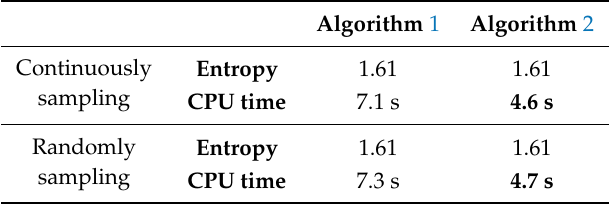
Figure 5. ISAR images obtained by the two proposed algorithms under different sampling schemes. Column 1: continuously sampling. Column 2: random sampling. Row 1: Algorithm 1. Row 2: Algorithm 2. Table 1. Entropies of the reconstructed images and CPU times of the proposed